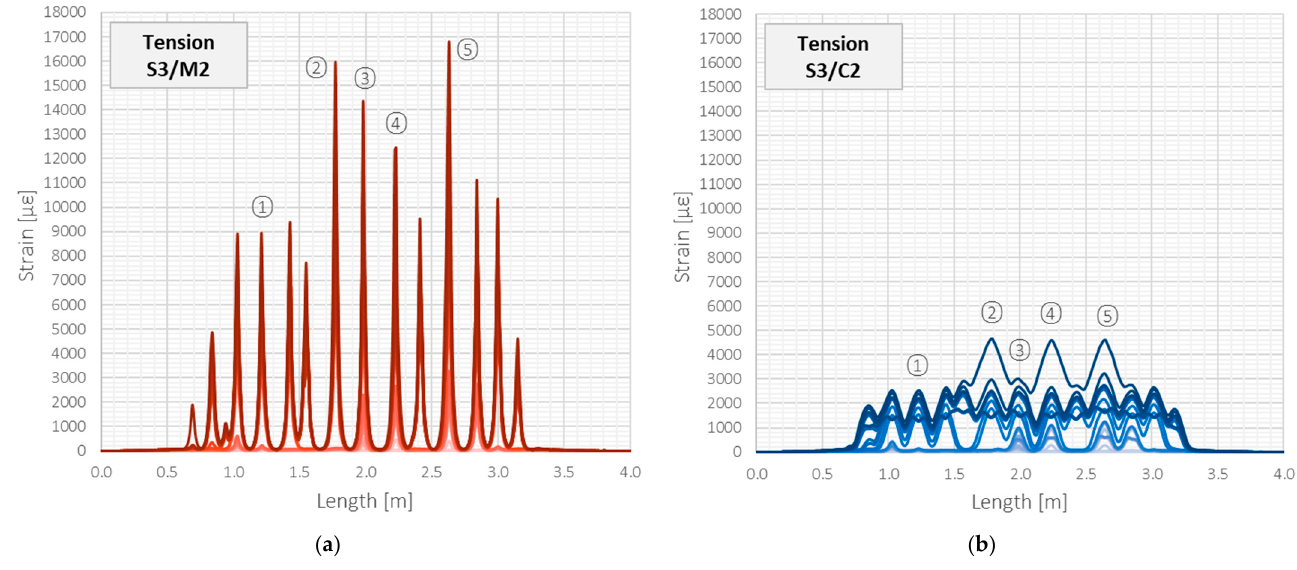
Figure 13. Beam S3/tension zone: strain profiles registered by ( a ) monolithic sensor M2 and ( b ) lay- ered sensing cable C2 with steel strengthening insert.